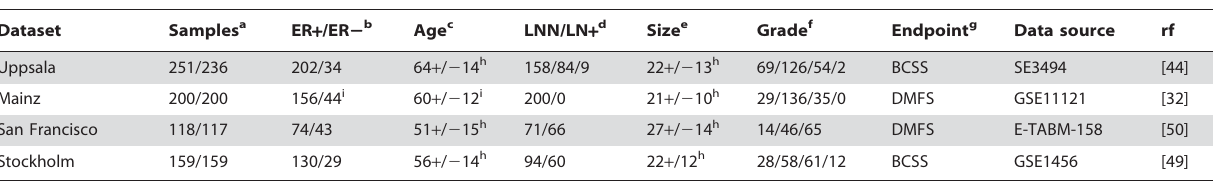
a Number of samples/Number of samples with survival data. b Estrogen receptor status. c Median age in years; mean age for Mainz. d Lymph Node status: LNN/LN + /unknown. e Average tumor size in cm. f Histological Grade: